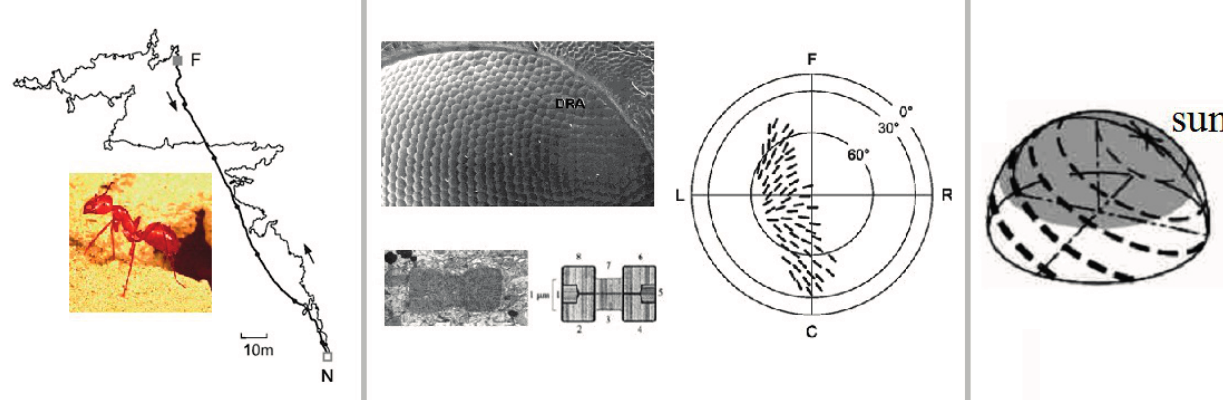
Figure 1. Left: The path integration of Cataglyphis for foraging and returning to the nest. Cataglyphis can navigate and positioning according to the polarization direction of the skylight and the odometer on their own. Middle: It includes the micrograph of the Cataglyphis ’ eye, the rhabdom of dumb-bell shape and its structure diagram. The rhabdom comprises two substances, which are mutually perpendicular. Such configuration enables the Cataglyphis to obtain the strength of the polarized light on one direction. In addition, it also includes the zenith projection of the array of the rhabdoms of the right eye of Cataglyphis bicolor . The black bars indicate the e-vector tuning axes of the (contralaterally looking) polarization analyzers. 0° horizon, C caudal, F frontal, L and R left and right visual hemisphere. Right: Three-dimensional representation of the polarization pattern under clear sky for 60° elevation of the sun. The bars indicate e-vector orientations as observed from the center of the hemisphere. Width of the bars represents the polarization